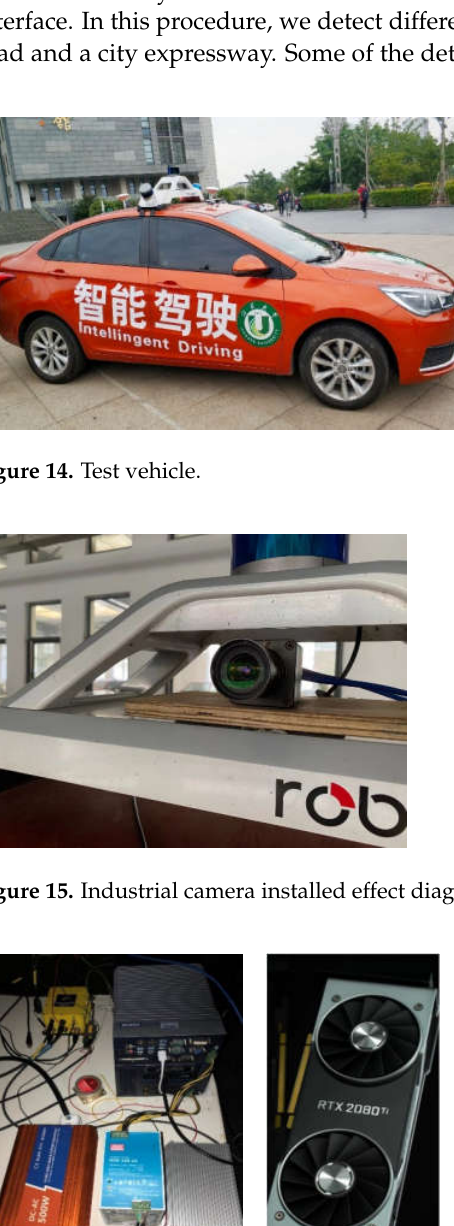
Figure 16. IPC and GPU: ( a ) IPC; ( b ) GPU.